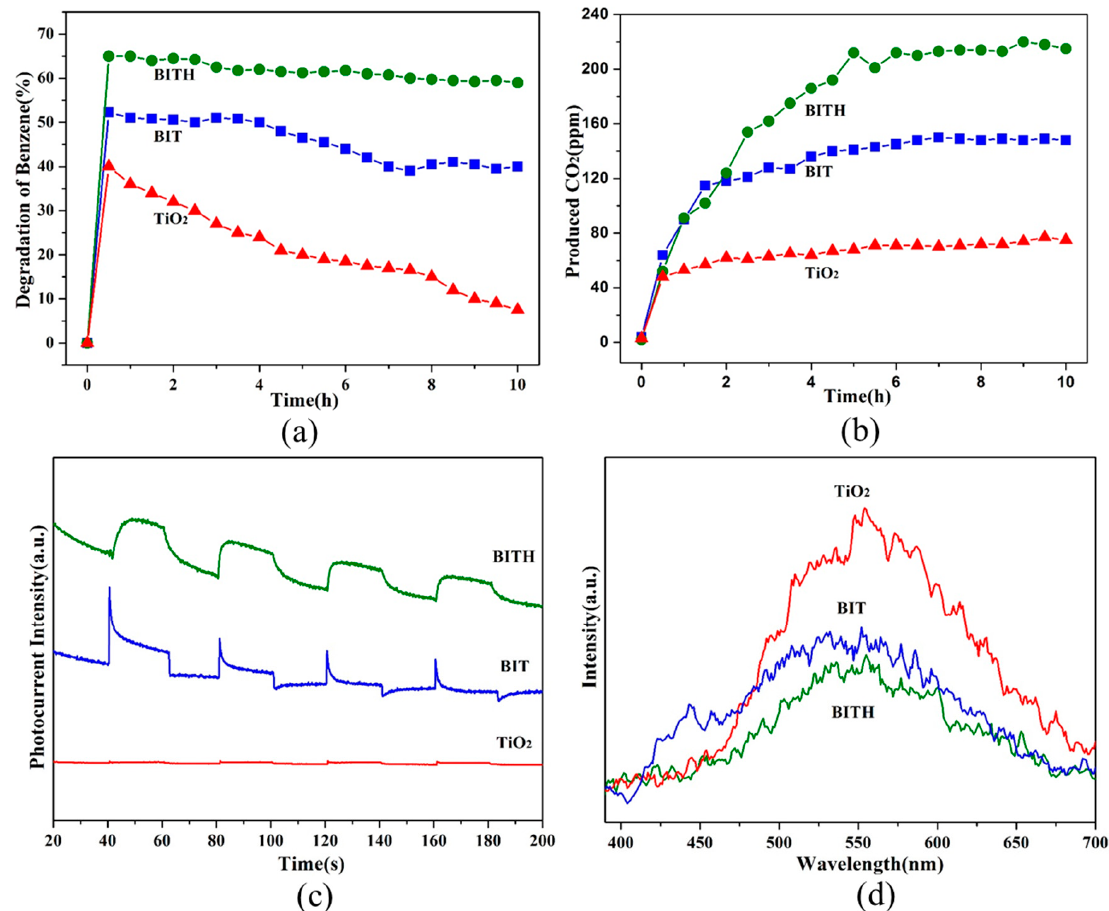
Figure 4. ( a ) Degradation of benzene, ( b ) produced CO 2 , ( c ) photocurrent patterns, and ( d ) fluorescence intensity (PL) patterns of BITH, BIT, and TiO 2 .